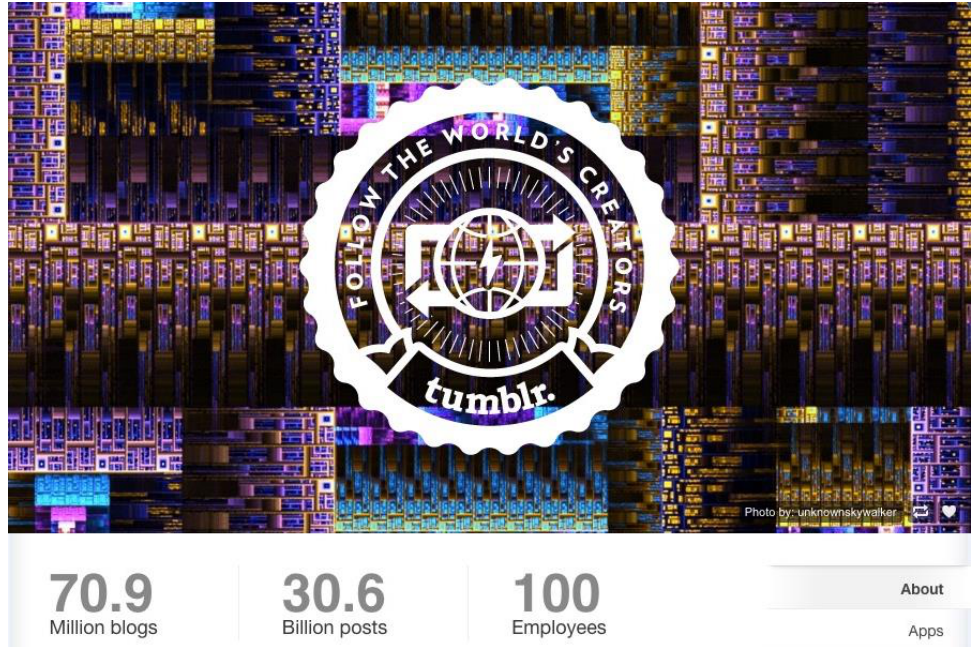
Figure 3. A screenshot from the Tumblr “About” page, 31 August 2012 [73].